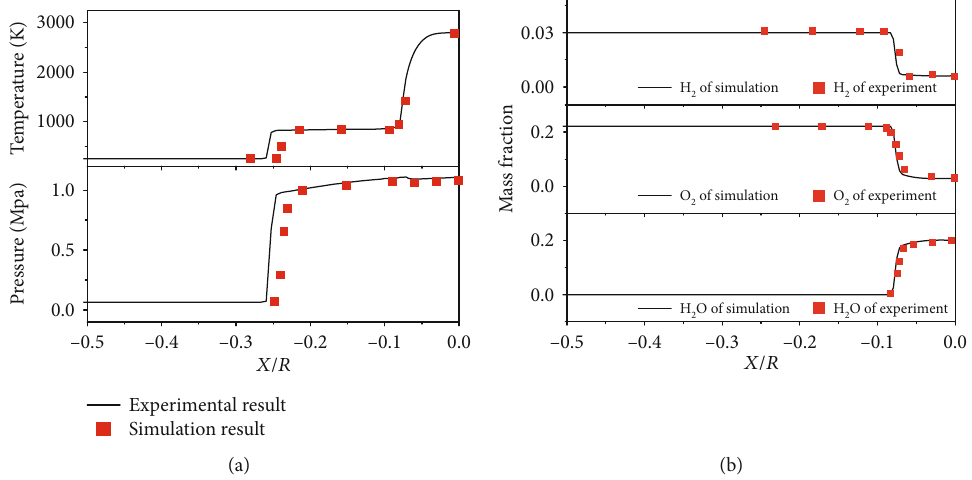
Figure 6: Distribution of temperature, pressure (a), and mass fractions (b) for a shock-induced